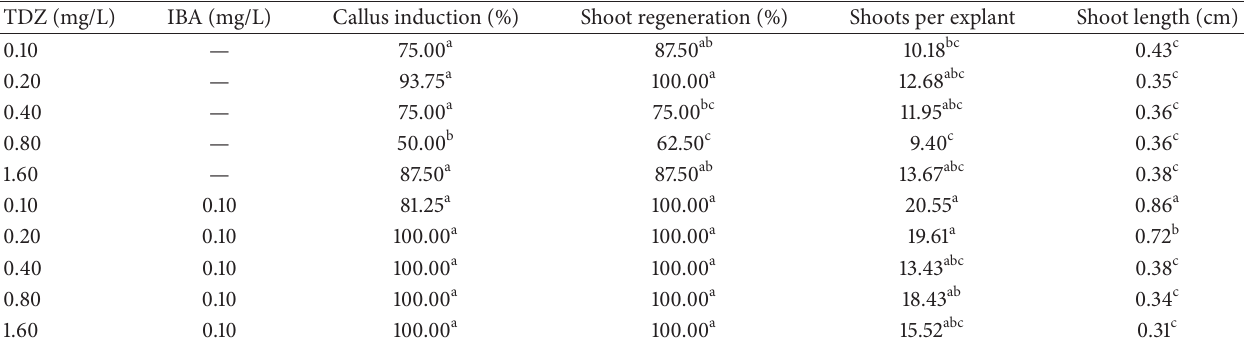
Table 2: Effects of different TDZ-IBA concentrations on shoot regeneration of H. polysperma from leaf